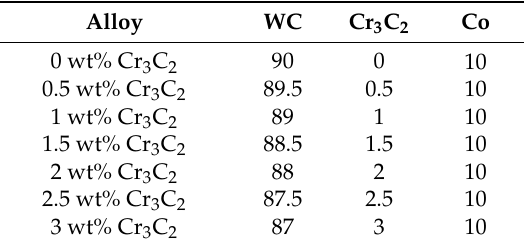
Table 1. Compositions in wt% of the seven alloys.